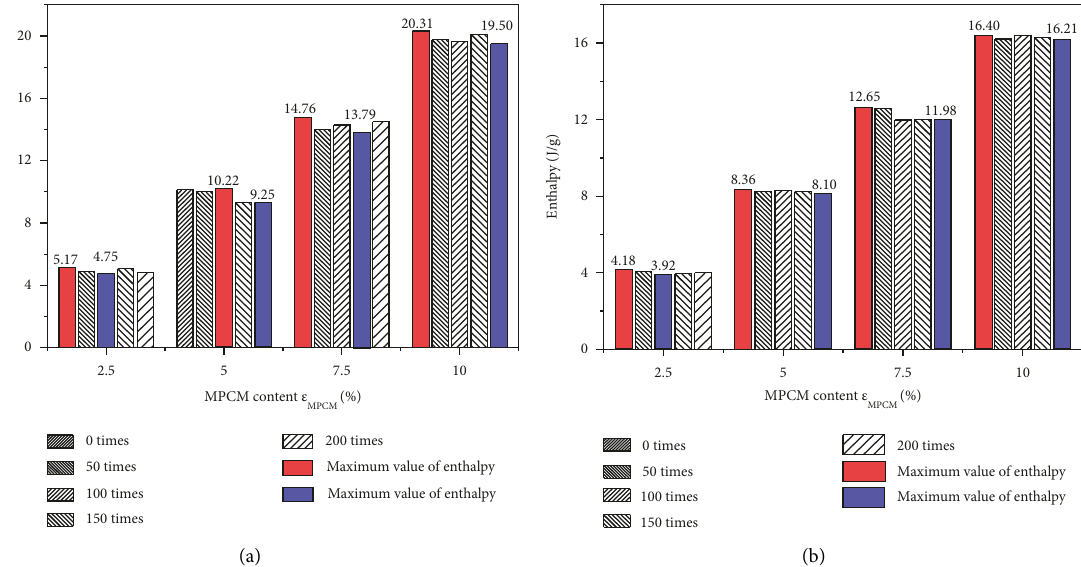
Figure 11: Effect of the phase-change cycle numbers on the enthalpy of MPCM-LWAC. (a) Heat absorption by melting. (b) Heat release by curing.